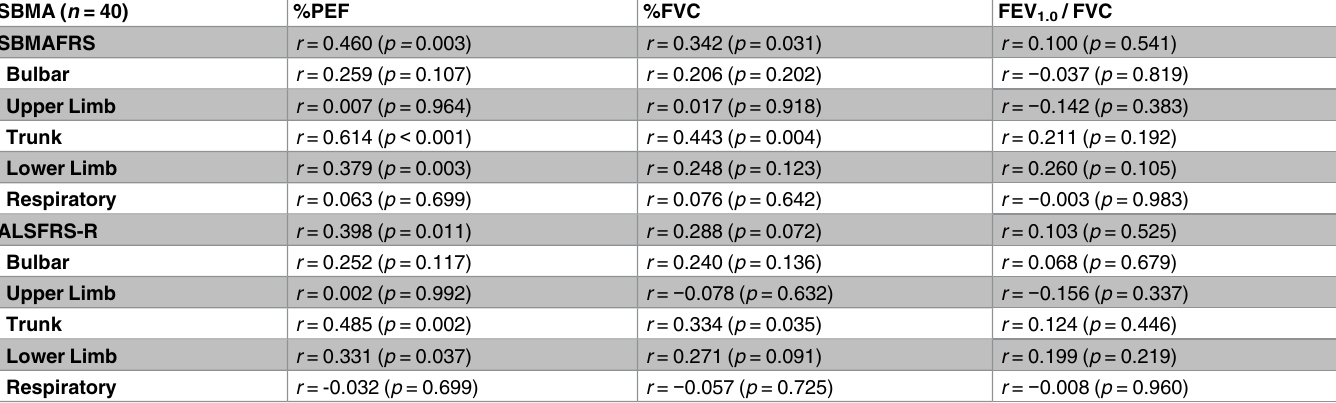
Table 2. Correlations between motor function scores and respiratoryindices in subjects with SBMA.